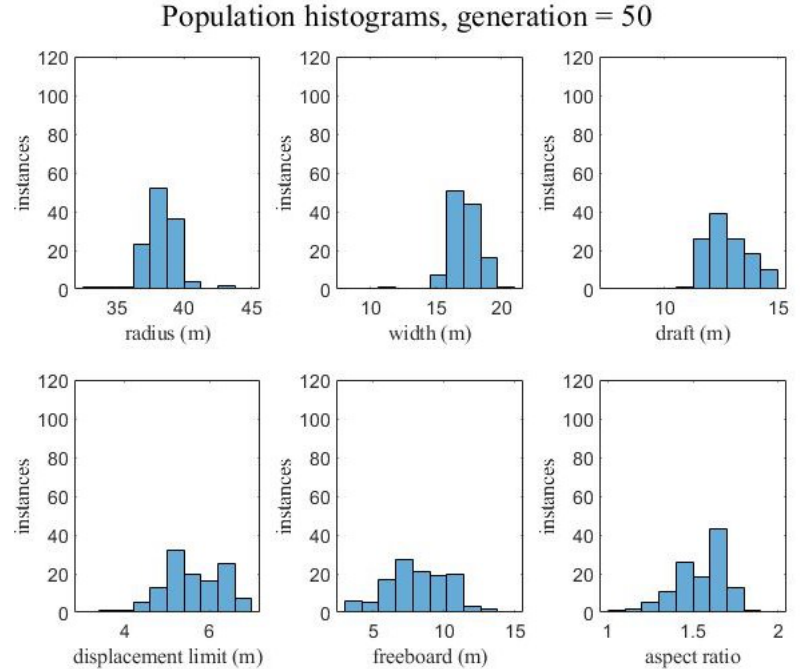
Figure 16. Population histogram for the 50th generation.